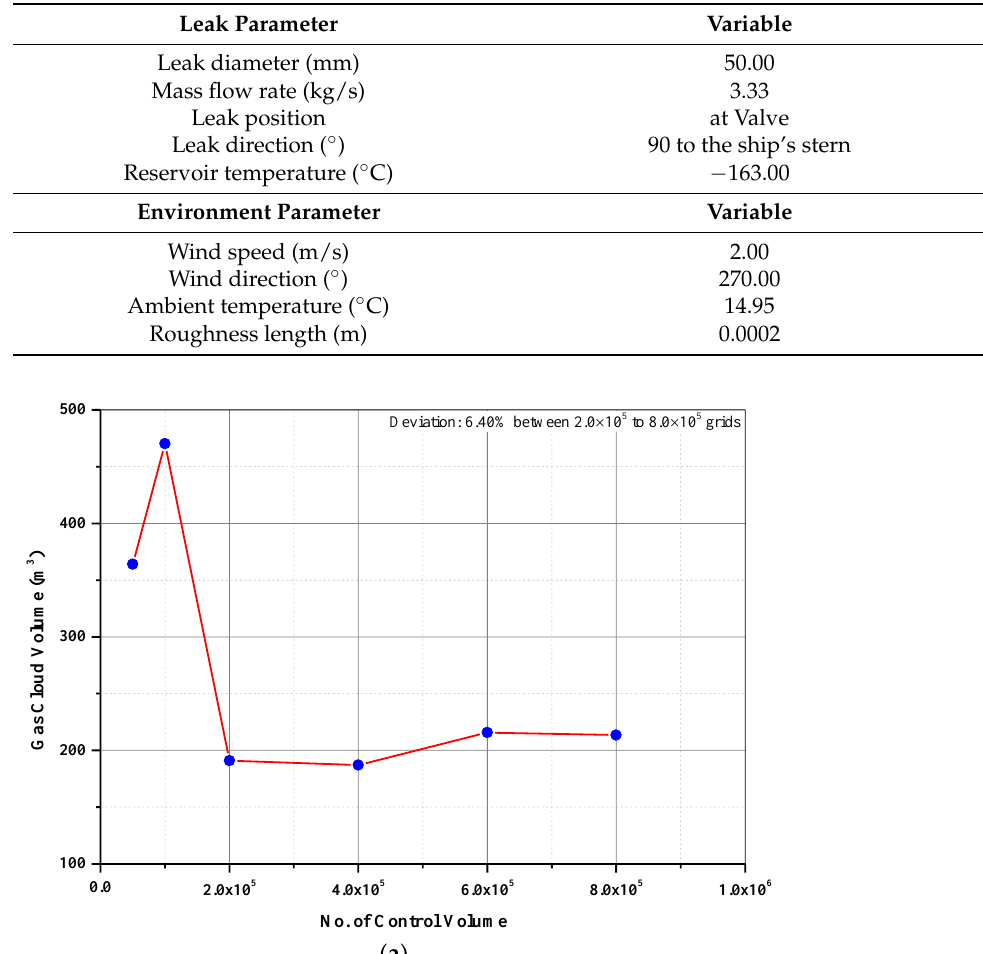
Figure 11. Section of the fluid domain and target ship with 600,000 grids: top view ( a ) and side view ( b ). Table 9. A gas release scenario for GCT and ICT.